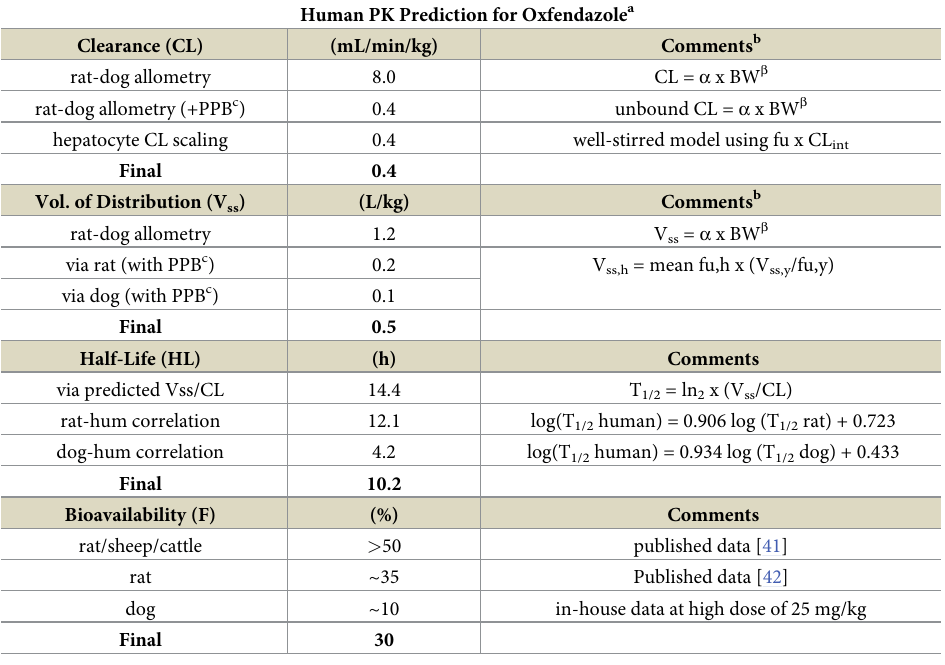
Table 1. Human pharmacokinetic prediction for